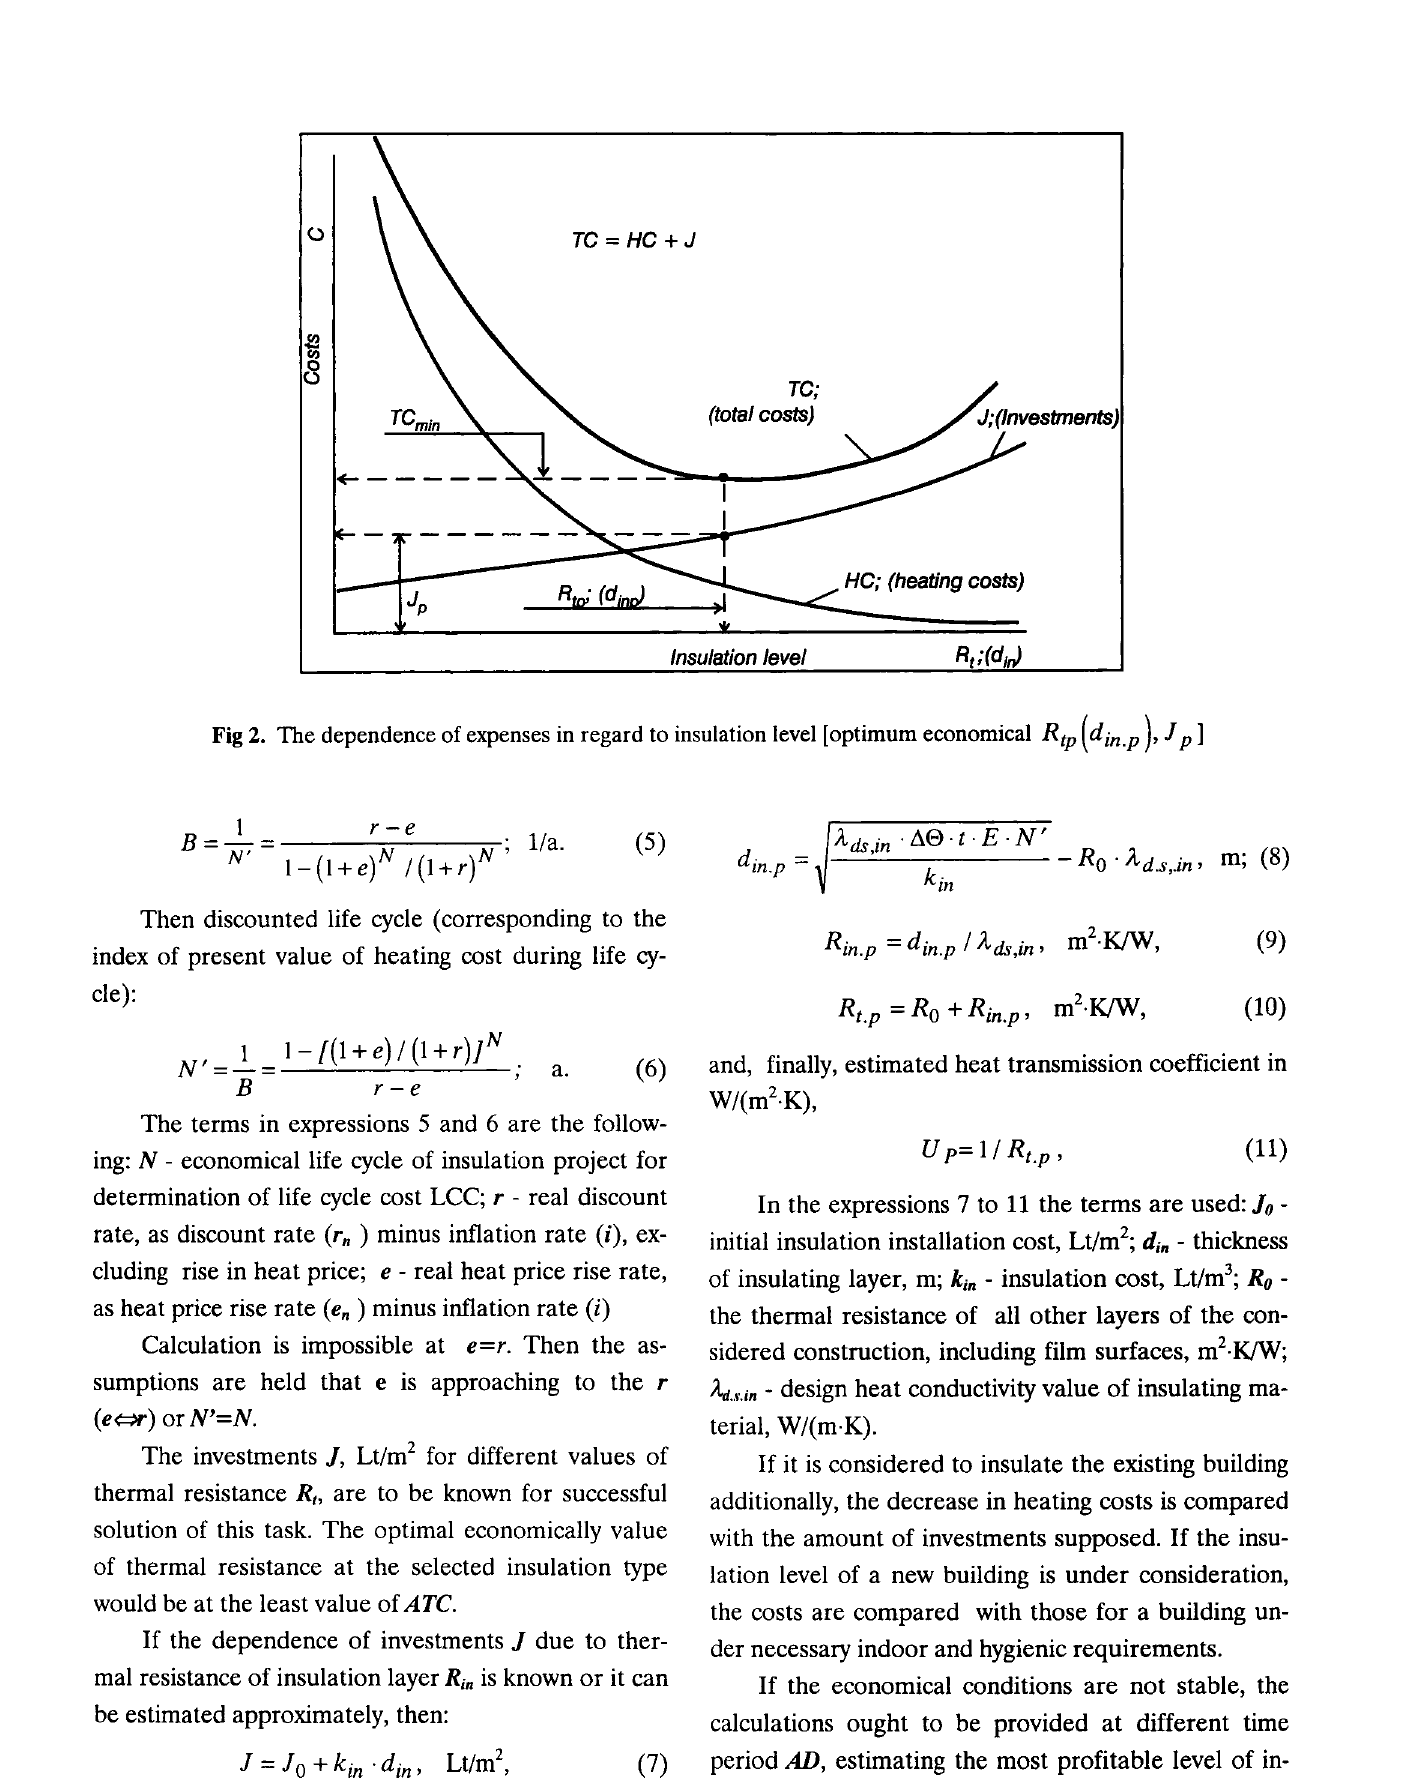
Fig 2. The dependence of expenses in regard to insulation level [optimum economical Rtp ( din.p ), J